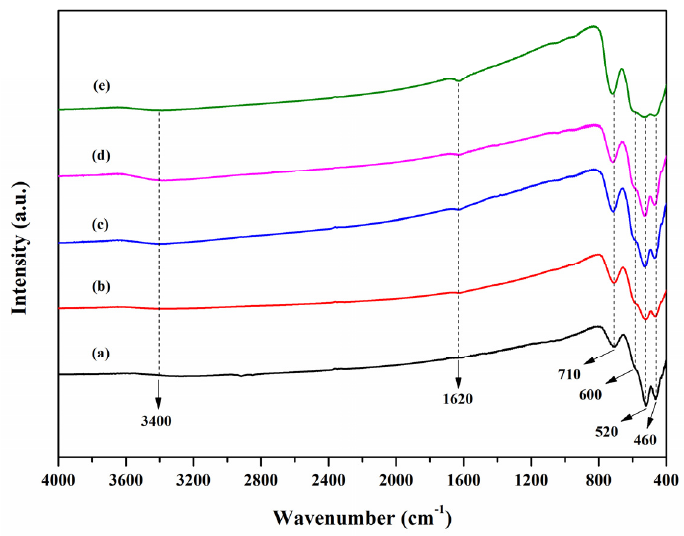
Figure 2. FT-IR spectra of ( a ) OMS-2, ( b ) 1Ni/OMS-2, ( c ) 3Ni/OMS-2, ( d ) 5Ni/OMS-2, and ( e ) 10Ni/OMS-2.